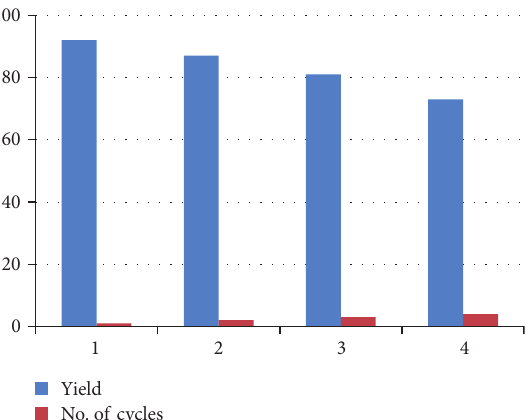
F 1: FT-IR spectra of silica-supported sodium hydrogen sulphate.